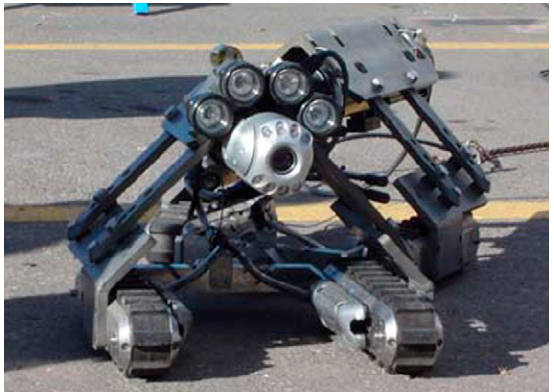
Figure 5. Closed-circuit television camera (CCTV) pipeline inspection from [144]. (Reprinted with permission from ref. [144]. Copyright 2021 Elsevier). permission from ref. [144]. Copyright 2021